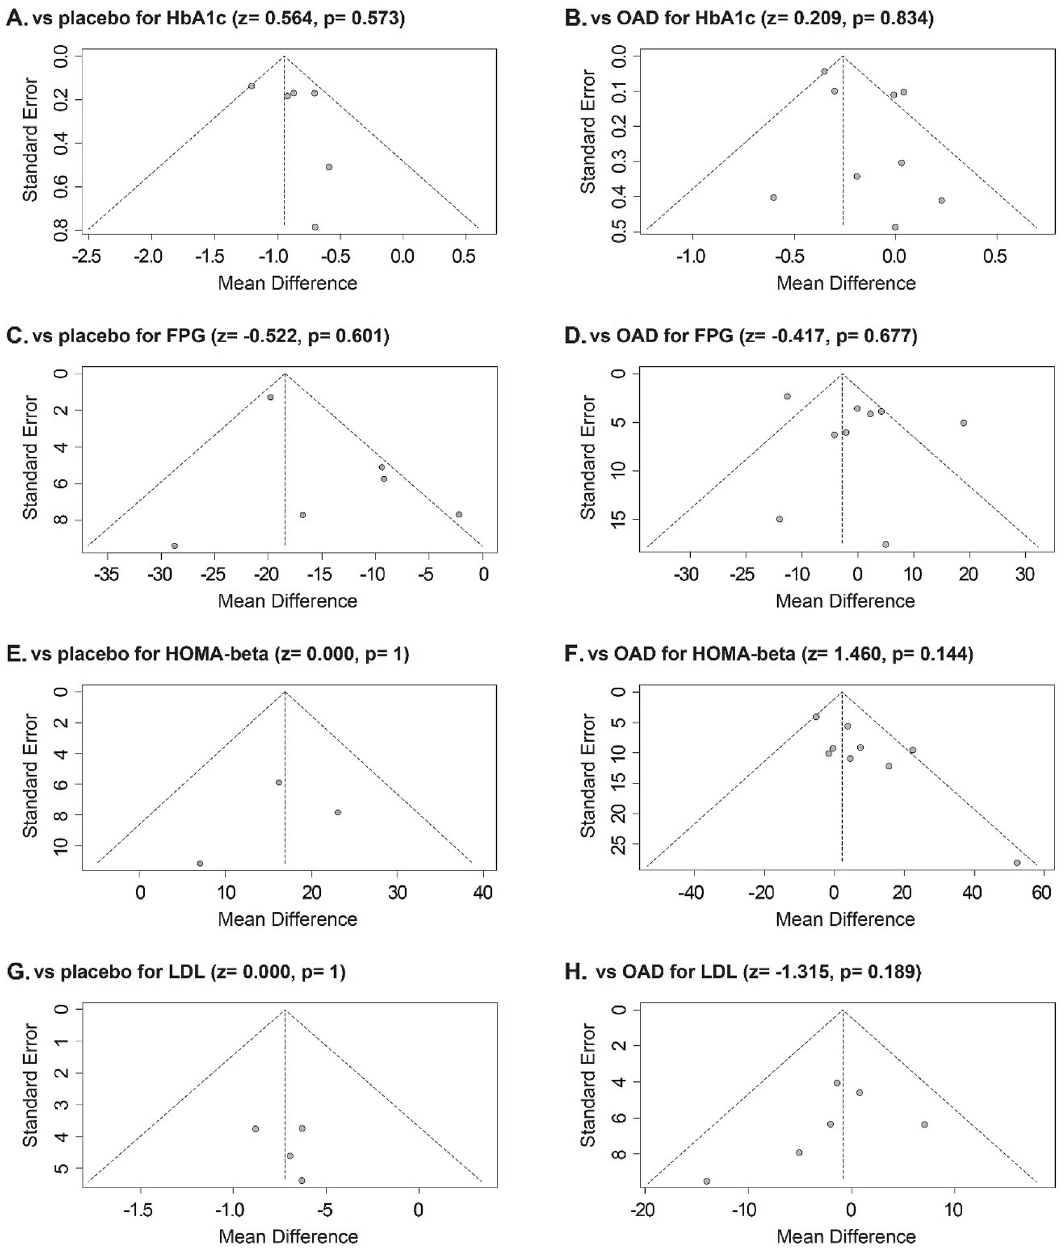
Figure 9. Funnel plots of the MDs versus the standard error of the MDs for HbA1c, FPG, HOMA-β, and